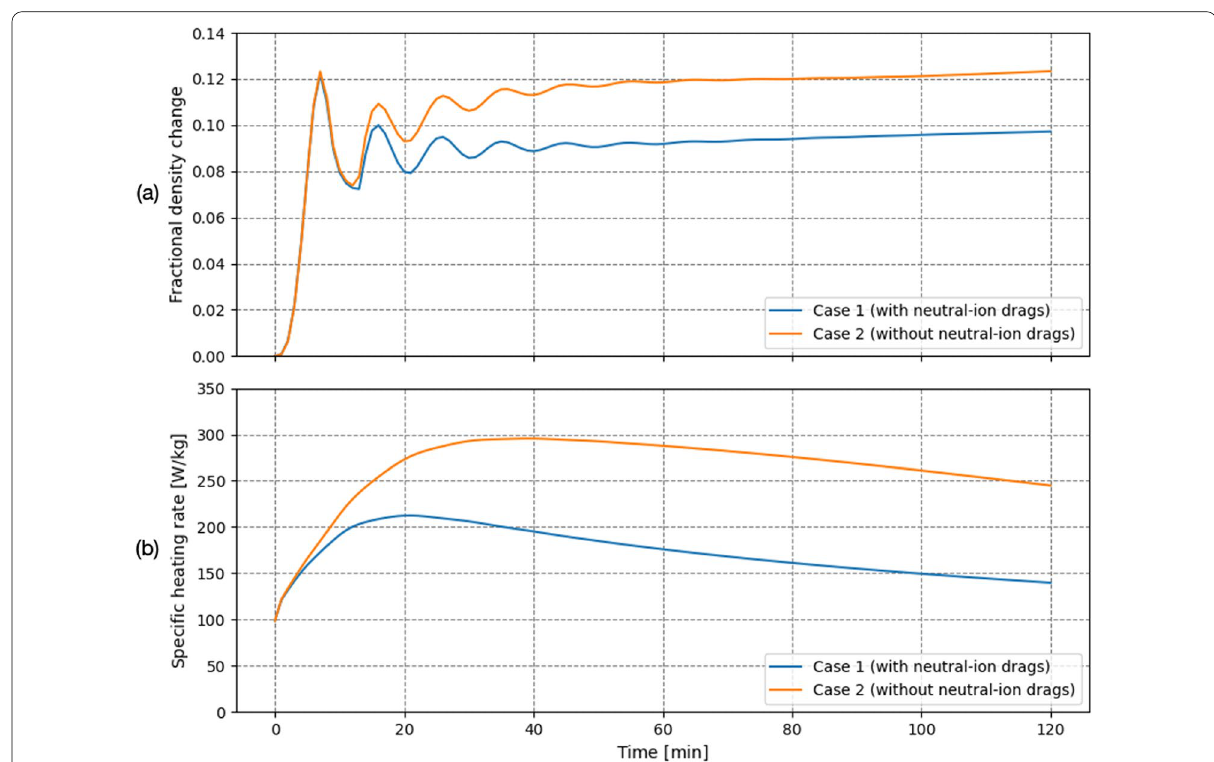
Fig. 4 The time evolution of the fractional density change (top) and specific heating rate (bottom) at the 400-km altitude in each